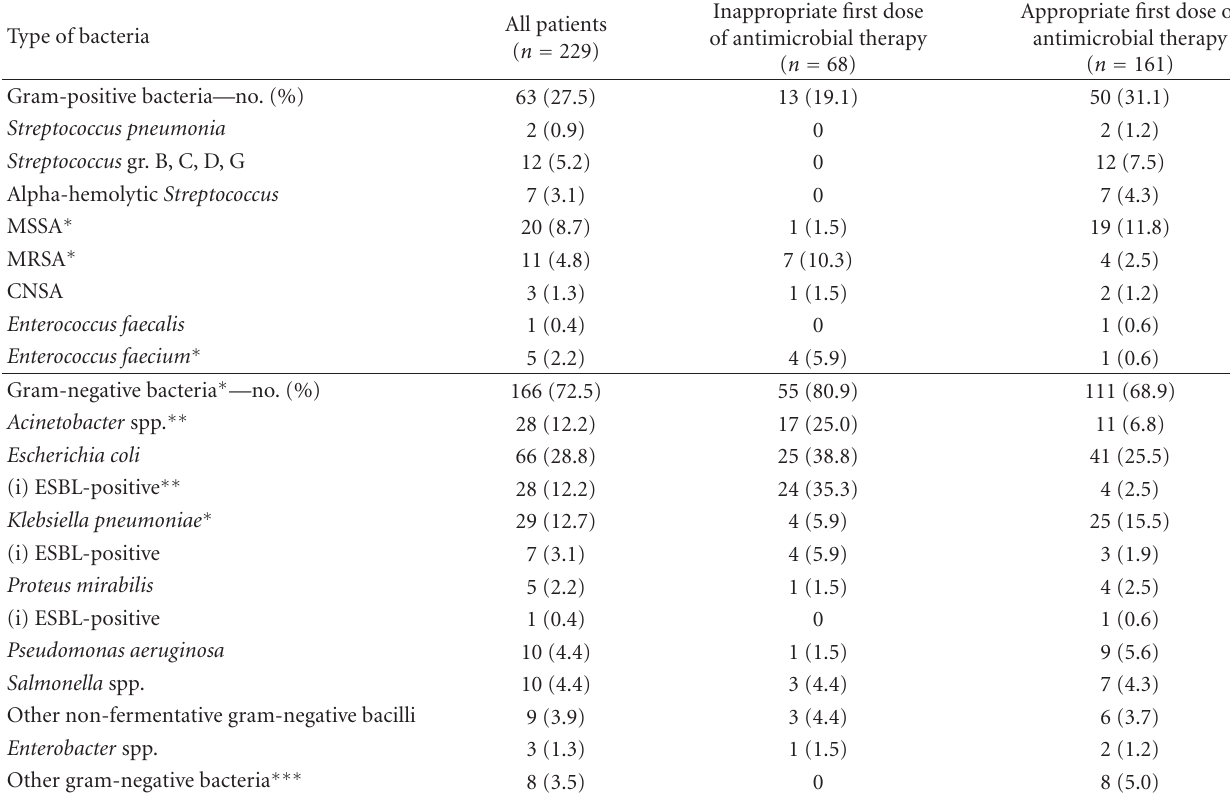
Table 3: Type of microorganism isolated from blood by appropriateness of empiric antimicrobial therapy. Type of bacteria